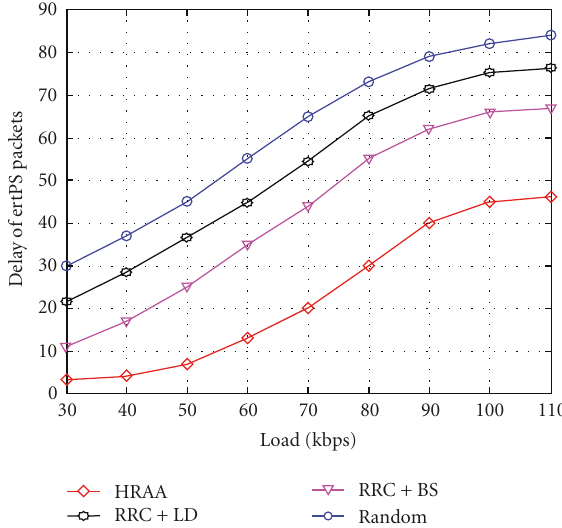
Figure 7: Delay comparison of ertPS SFs in outer ring cell versus load.